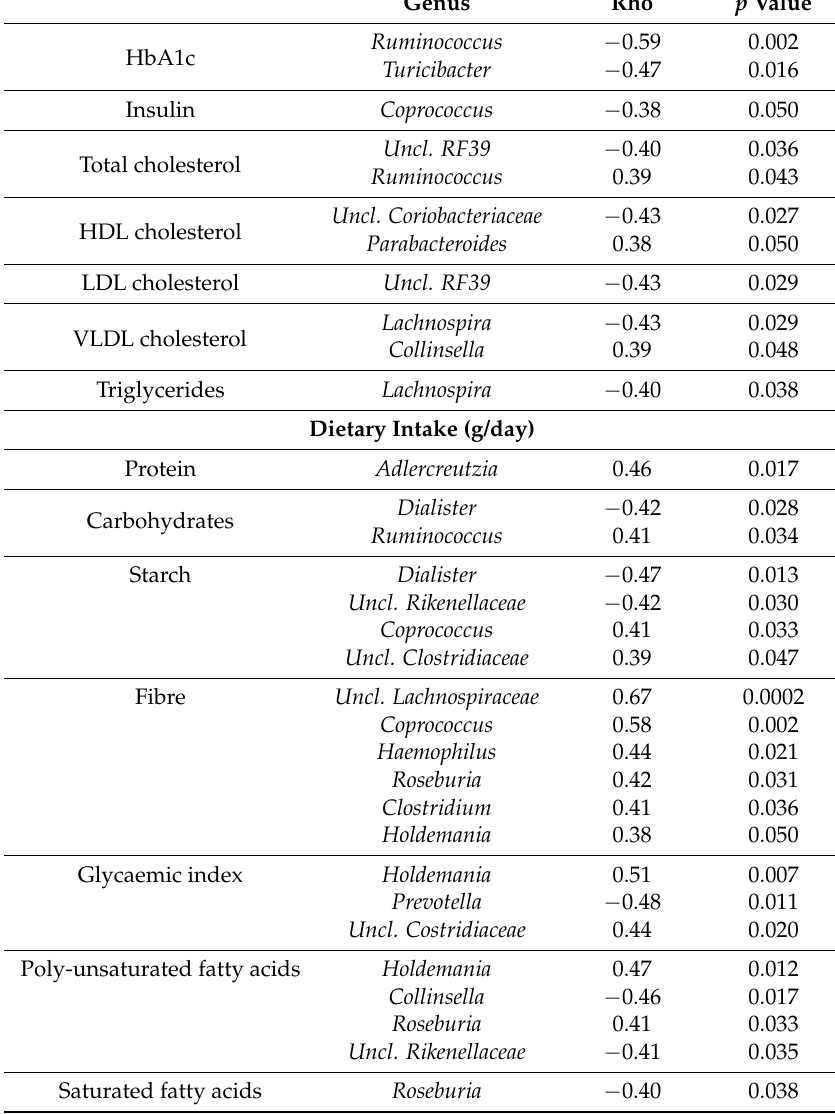
Table 3. Correlations between specific genera and clinical characteristics and dietary